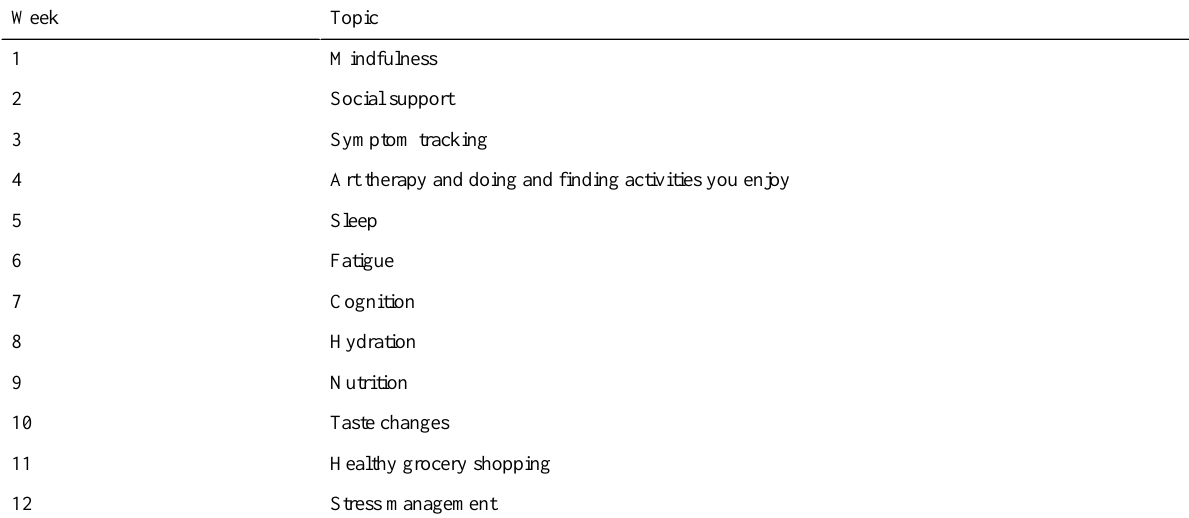
Table 6. Weekly healthy lifestyle control group call